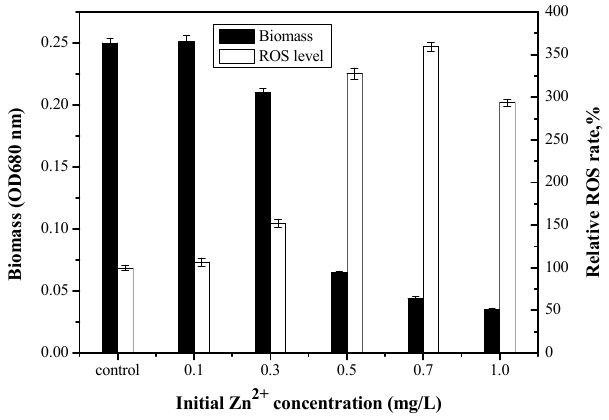
Figure 4. Inhibition of Anabaena sp. growth and relative ROS rate at different initial concentrations of Zn 2+ .